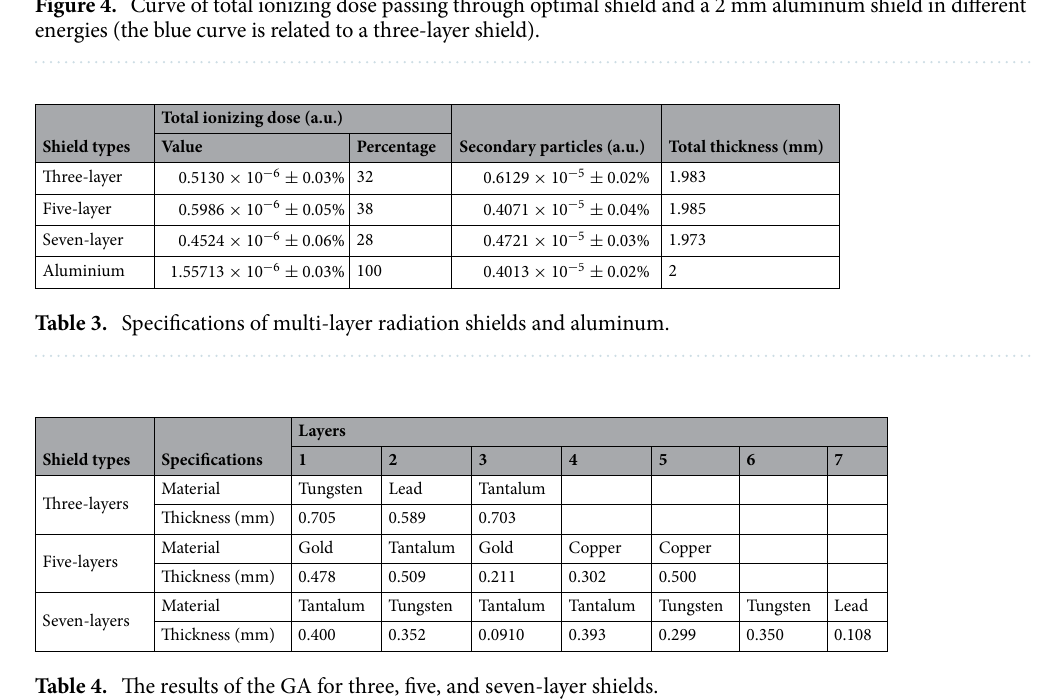
Table 4. The results of the GA for three, five, and seven-layer shields.